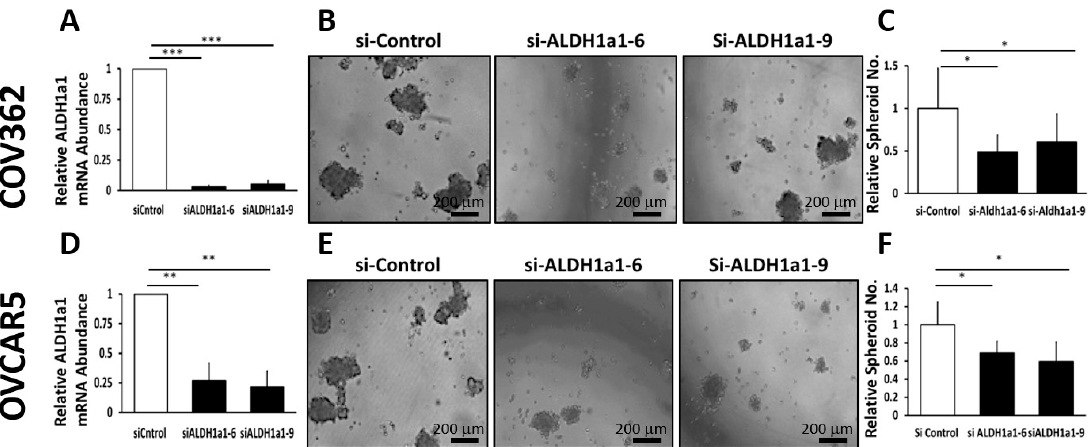
Figure 4. Effects of ALDH1A1 depletion on sphere formation. ( A ) COV362 cells were transfected with 50 nM scrambled siRNA (si-Control) or siRNA targeting ALDH1A1 (si-ALDH1A1 sequences #6 and #9); ALDH1A1 knockdown was assessed by qRT-PCR. ( B ) COV362 were plated under low attachment conditions for six days; spheres were photographed under 100 × magnification. ( C ) The numbers of spheres per well were counted (five fields per well); graph depicts fold-change. ( D ) OVCAR5 cells were transfected with 50 nM si-Control or si-ALDH1A1 siRNA; cells were assessed for ALDH1A1 knockdown by qRT-PCR analysis. ( E ) OVCAR5 cells were plated under low attachment conditions for six days; spheres were photographed under 100 × magnification. ( F ) The number of spheres per well were counted (five fields per well); graph depicts fold-change between cells transfected with control and ALDH-targeting siRNA. Bars represent averages of triplicate measurements; *** corresponds to p < 0.001; ** corresponds to p < 0.01; * corresponds to p < 0.05.